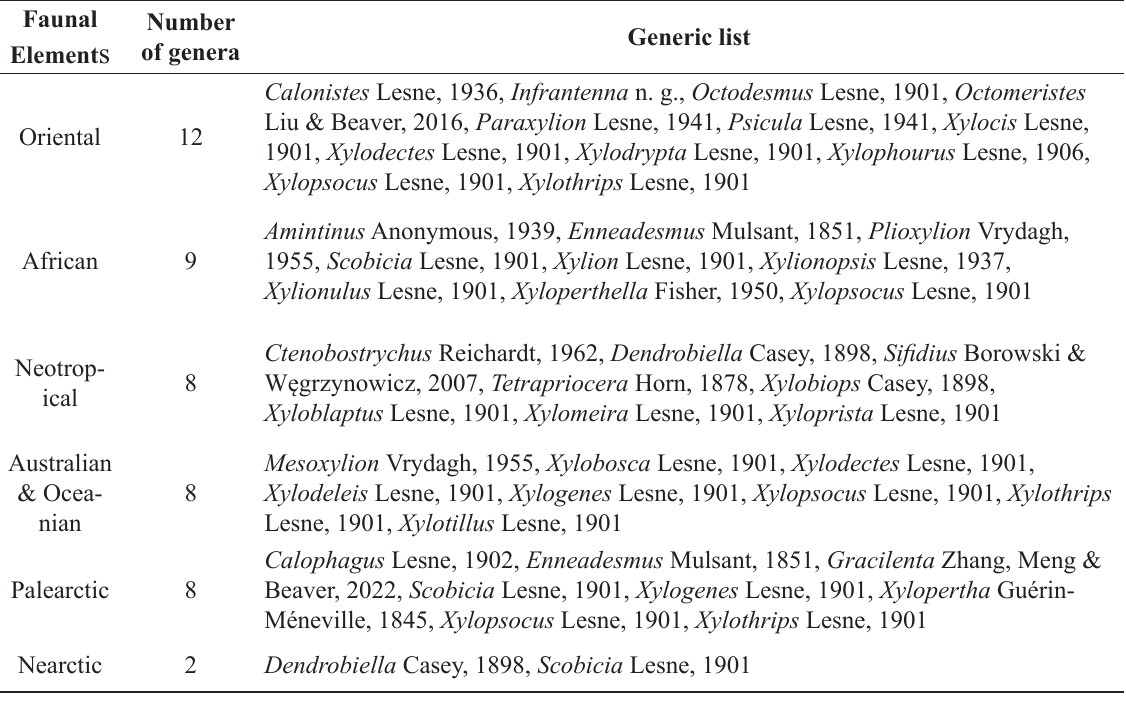
Table 3. Faunal elements of Xyloperthini Lesne, 1921 (see Discussion for further